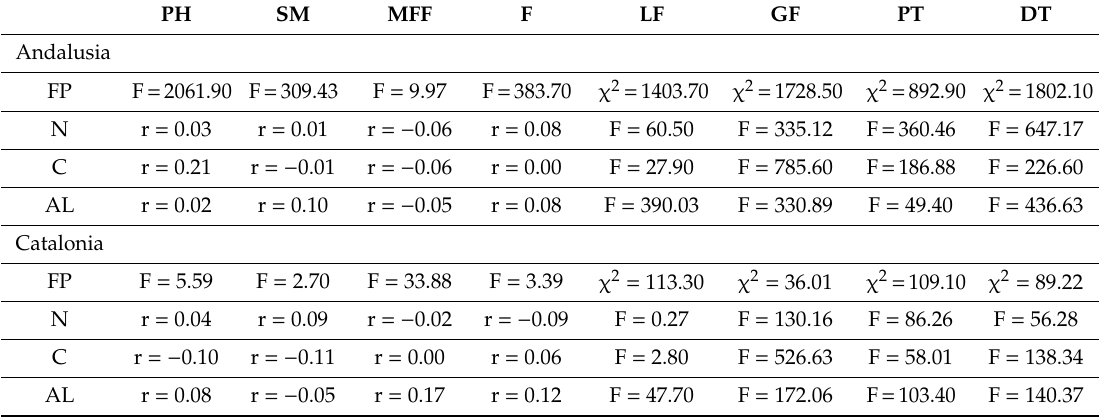
Table 6. Relationship between functional traits and field position (FP), nitrogen content (N), clay content (C), and arable land (AL) provided by the Fourth-corner analyses. None of the relationships were significant ( p > 0.05 in all